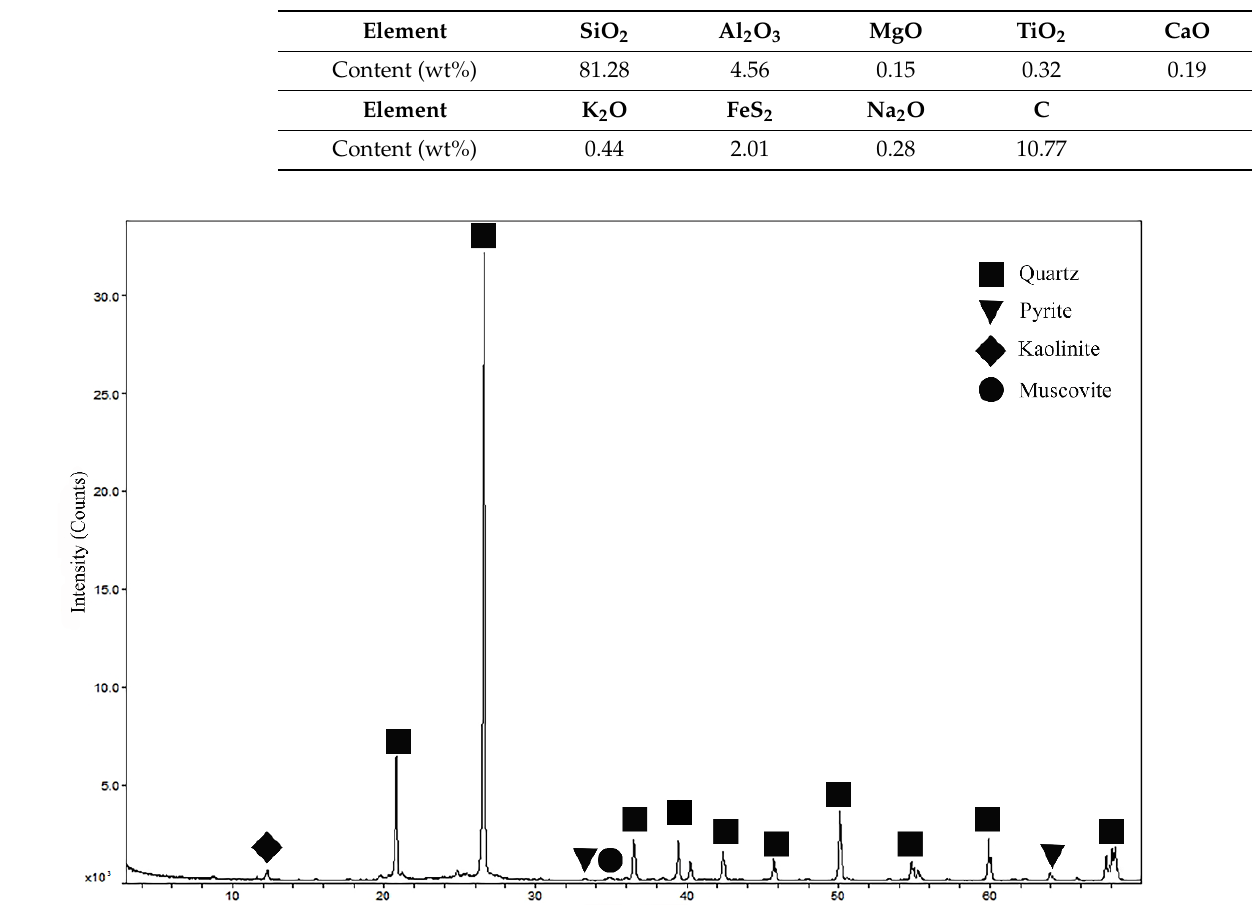
Table 1. Multi-element analysis of the ore sample by ICP-MS and EA.